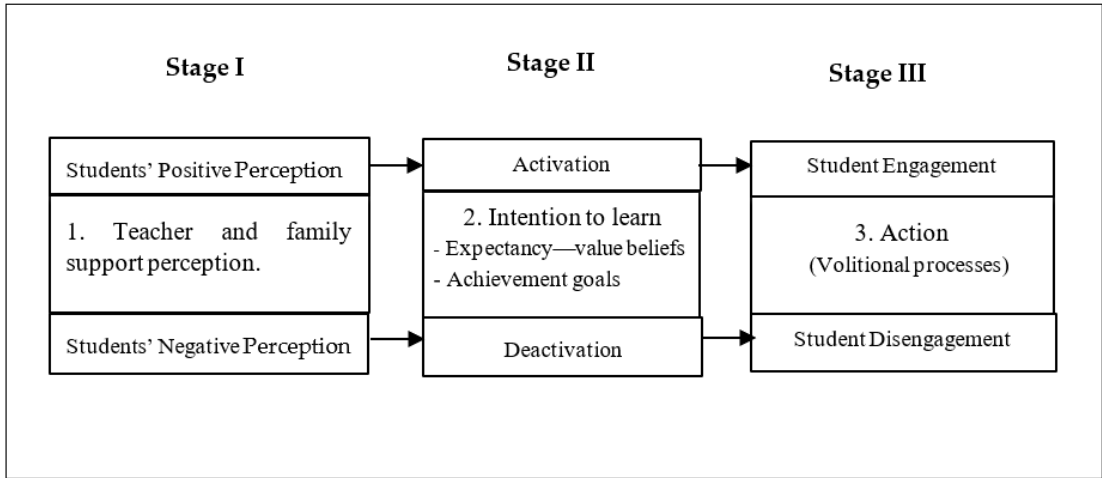
Figure 2. Adaptation of the MOCSE general framework to study student engagement.